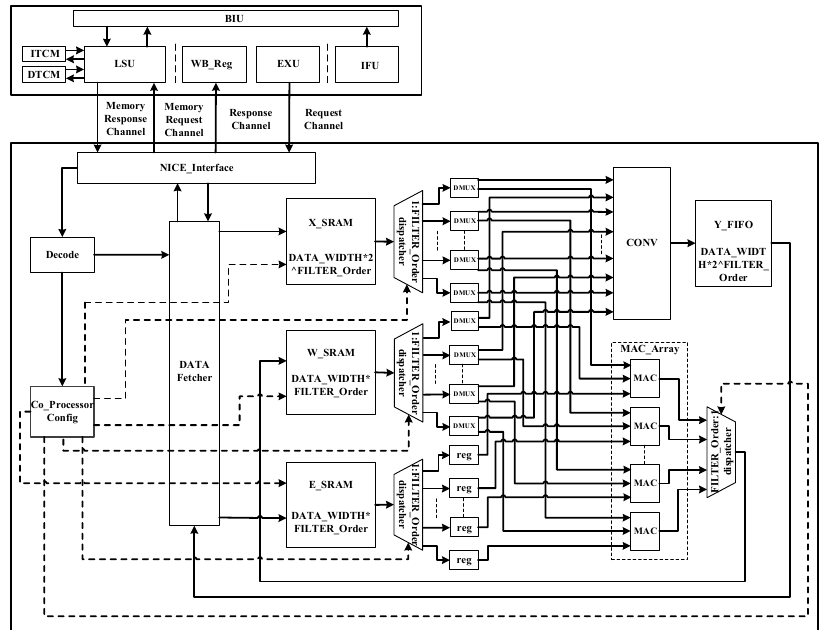
Figure 6. Circuit structure diagram of audio denoising coprocessor.